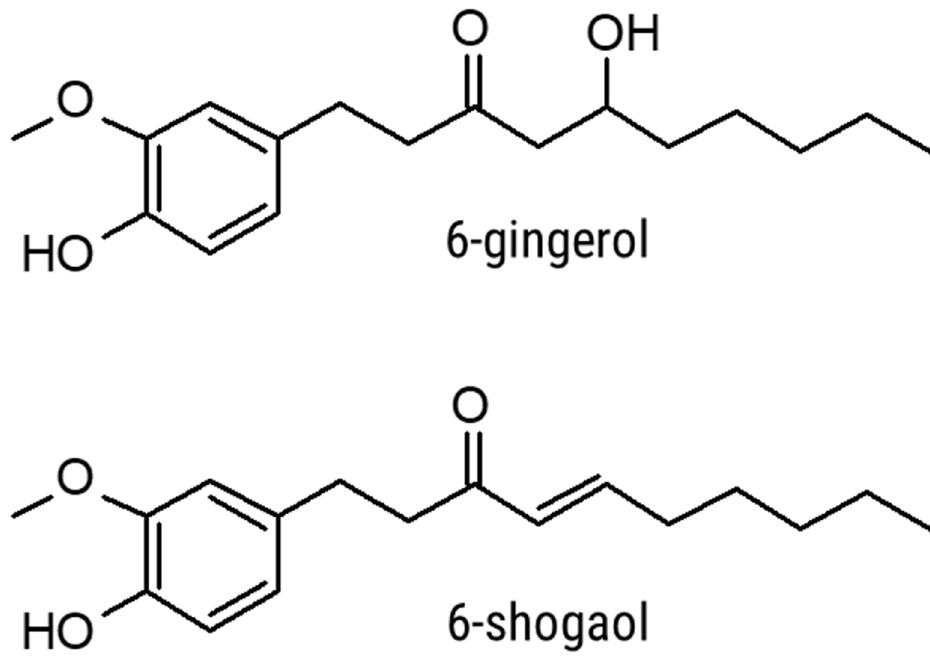
Figure 1. The structures of 6-gingerol and 6-shogaol.